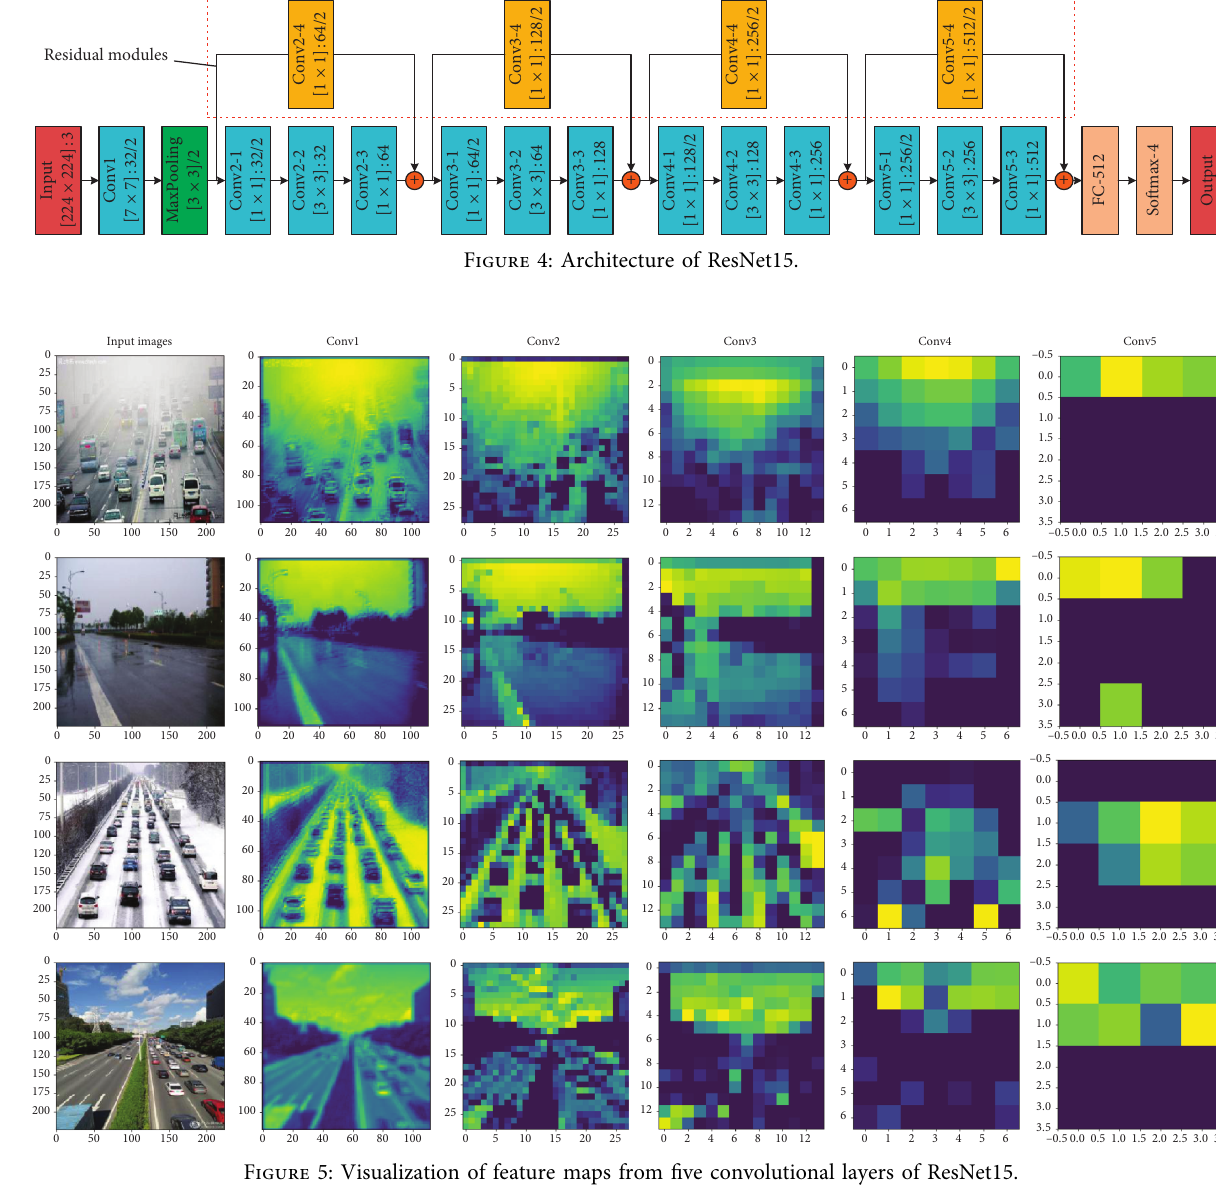
Figure 5: Visualization of feature maps from five convolutional layers of ResNet15.